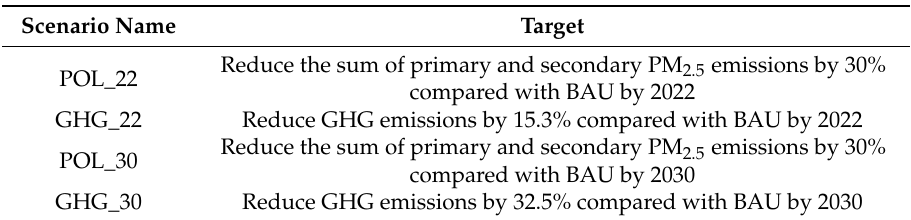
Table 6. Scenario building for analysis.